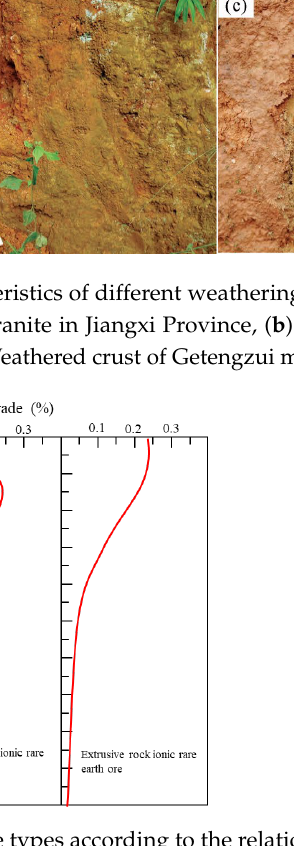
Figure 4. Ionic rare earth ore types according to the relationship between rare earth grade and ore body depth.